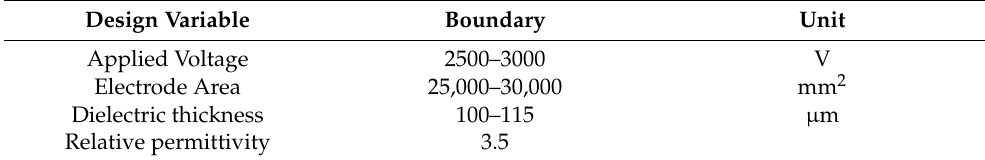
Table 5. Constraints for Optimal